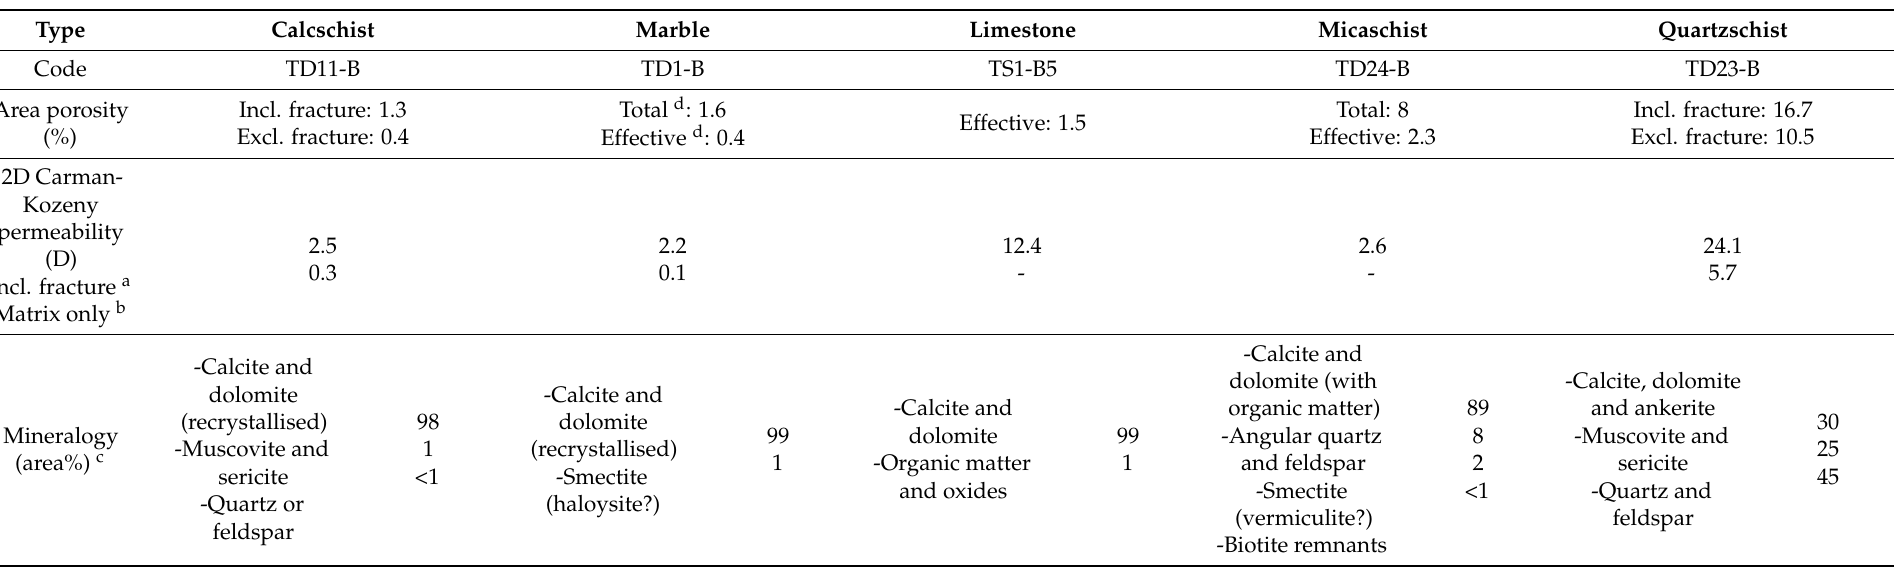
Table 7. Image analyses results and mineralogy obtained from thin section analyses on several Kızıldere samples. Note that the shown 2D permeability values are overestimated by at least one order of magnitude due to the stress-free matrix and potential preparation